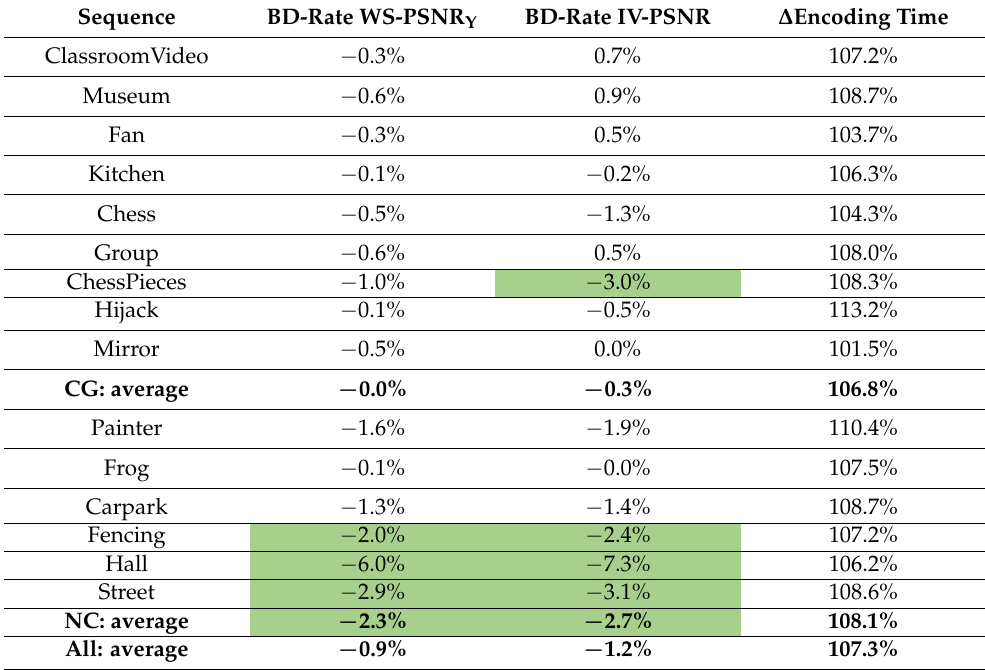
Table 1. Basic SCC vs. SCC with quarter-pel IBC accuracy; BD-rates for two used quality metrics (WS-PSNR and IV-PSNR, a negative value indicates increased coding efficiency) and increase of the encoding time when compared to basic SCC (value higher than 100% indicates longer computational time); BD-rate change higher than 2% was highlighted in green (for efficiency